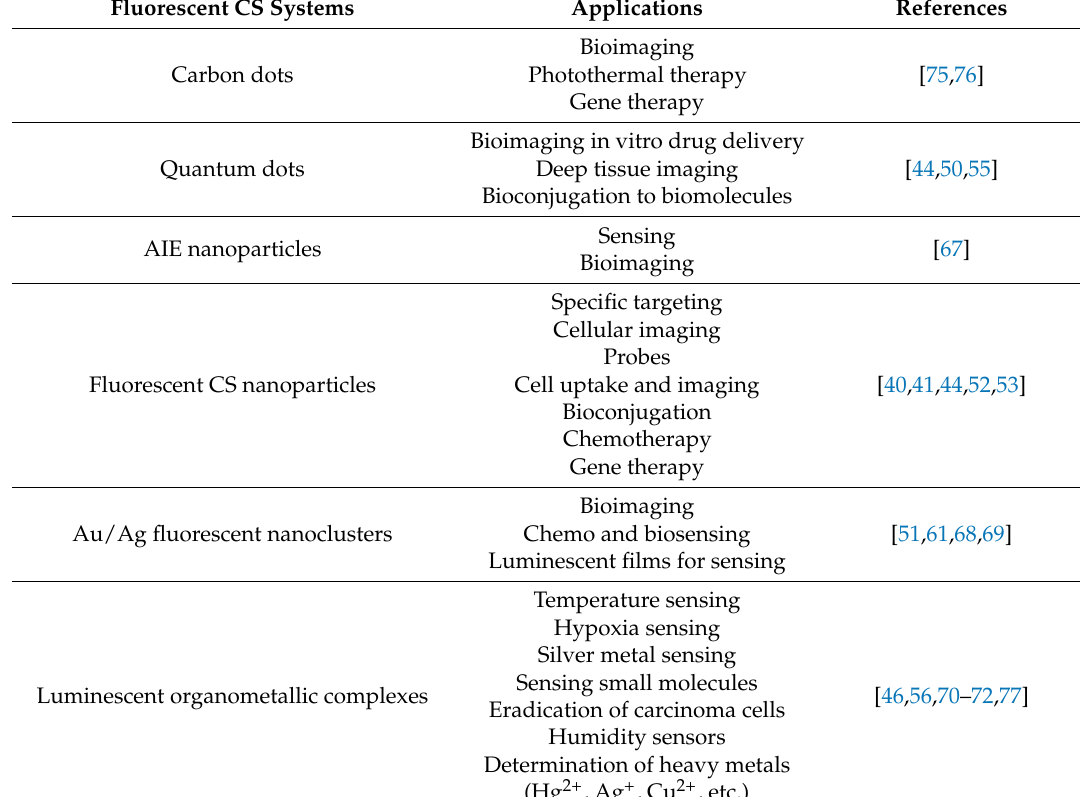
Table 1. Some selective CS based fluorescent systems and their